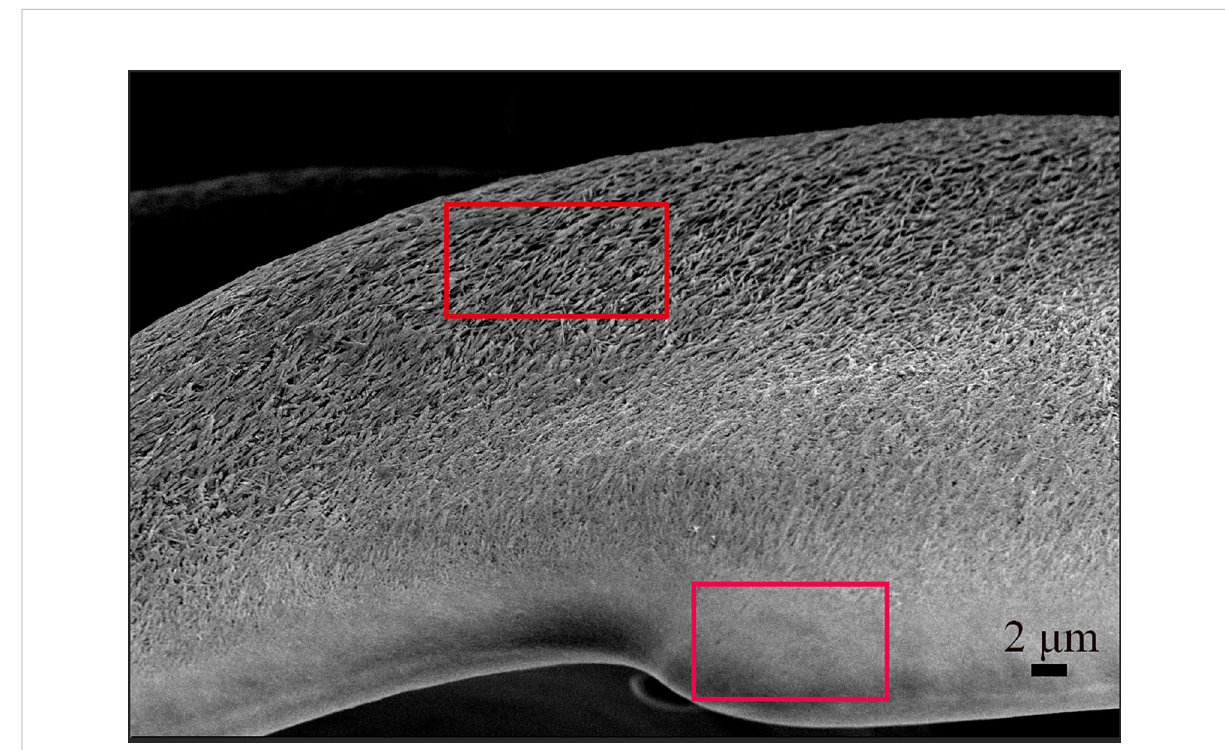
FIGURE 4 The microstructure of the limpet teeth. Bottom frame: small needles goethite packed tightly on the anterior side of the cusp; Top frame: big needles goethite packed loosely on the posterior part of the